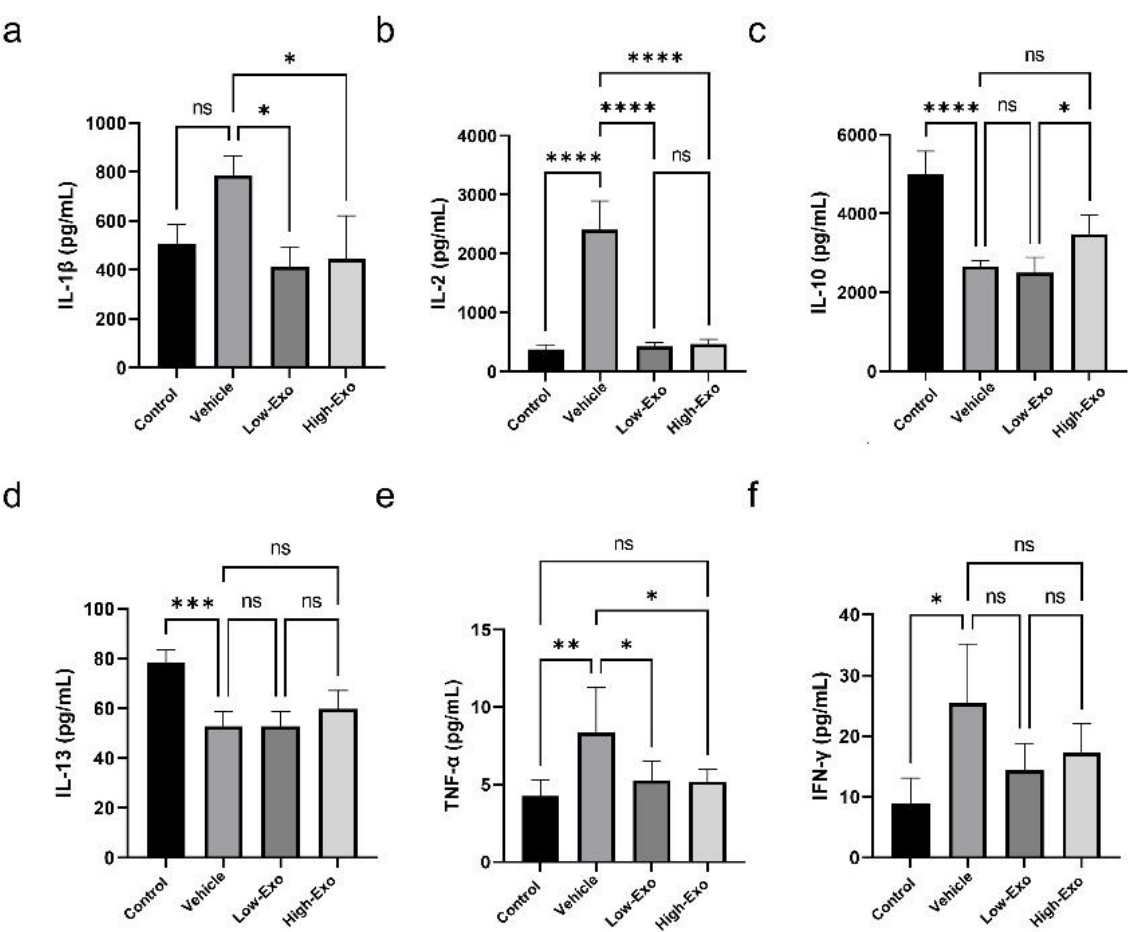
Figure 6. Cytokine levels in rats of the control and SCI groups: ( a – f ) levels of cytokines IL-1β, IL-2, IL-10, IL-13, TNF- α , and IFN- γ were analyzed in the serum of the control and SCI-induced rats (* p ≤ 0.05, ** p ≤ 0.01, *** p ≤ 0.001, **** p ≤ 0.0001, ns = not significant).